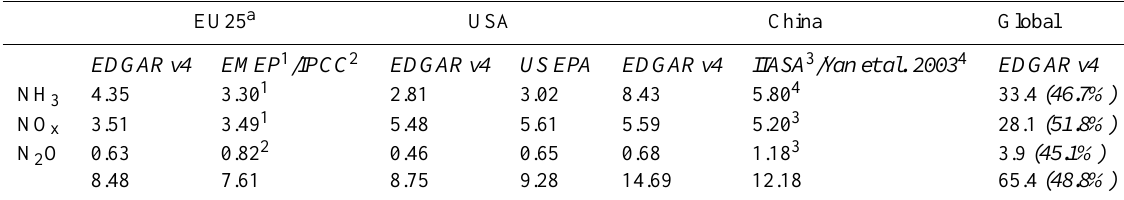
Table 2. Emissions inTgNitrogen (Tg N) for the three regions analysed in this paper based on a global inventory (EDGAR v4) and national submissions (to EMEP, IPCC) for the year 2005. In the case of the China, no official national inventory was available; NH 3 emissions as estimated for 2006 by Yan et al. (2003) and other data from the IIASA GAINS China model have been used for the comparison. The last column shows global figures ofTgN emitted based on the EDGAR v4 dataset, as well as the share of emissions of the three regions investigated contributing to global emissions in brackets and italics